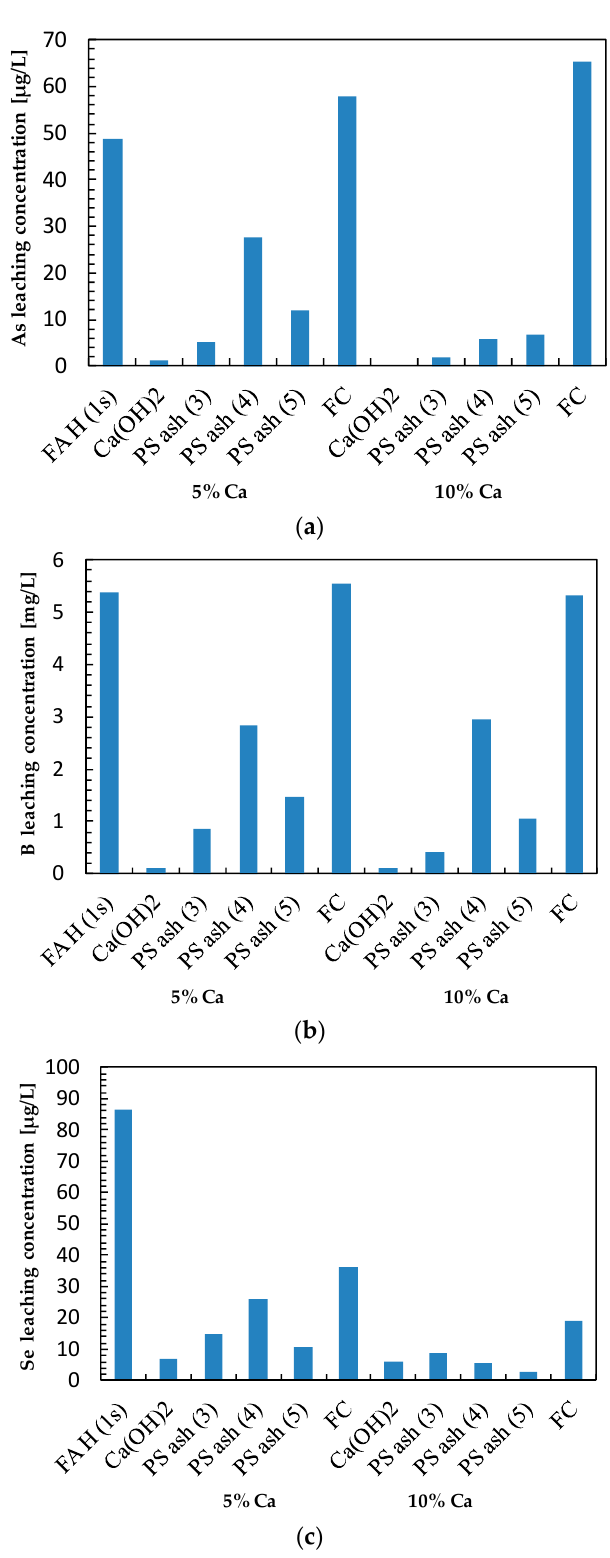
Figure 5. Trace element leaching concentration for fly ash H alone, and fly ash H under five kinds of additives addition for 5% and 10% Ca content samples: ( a ) arsenic; ( b ) boron; and ( c ) selenium.